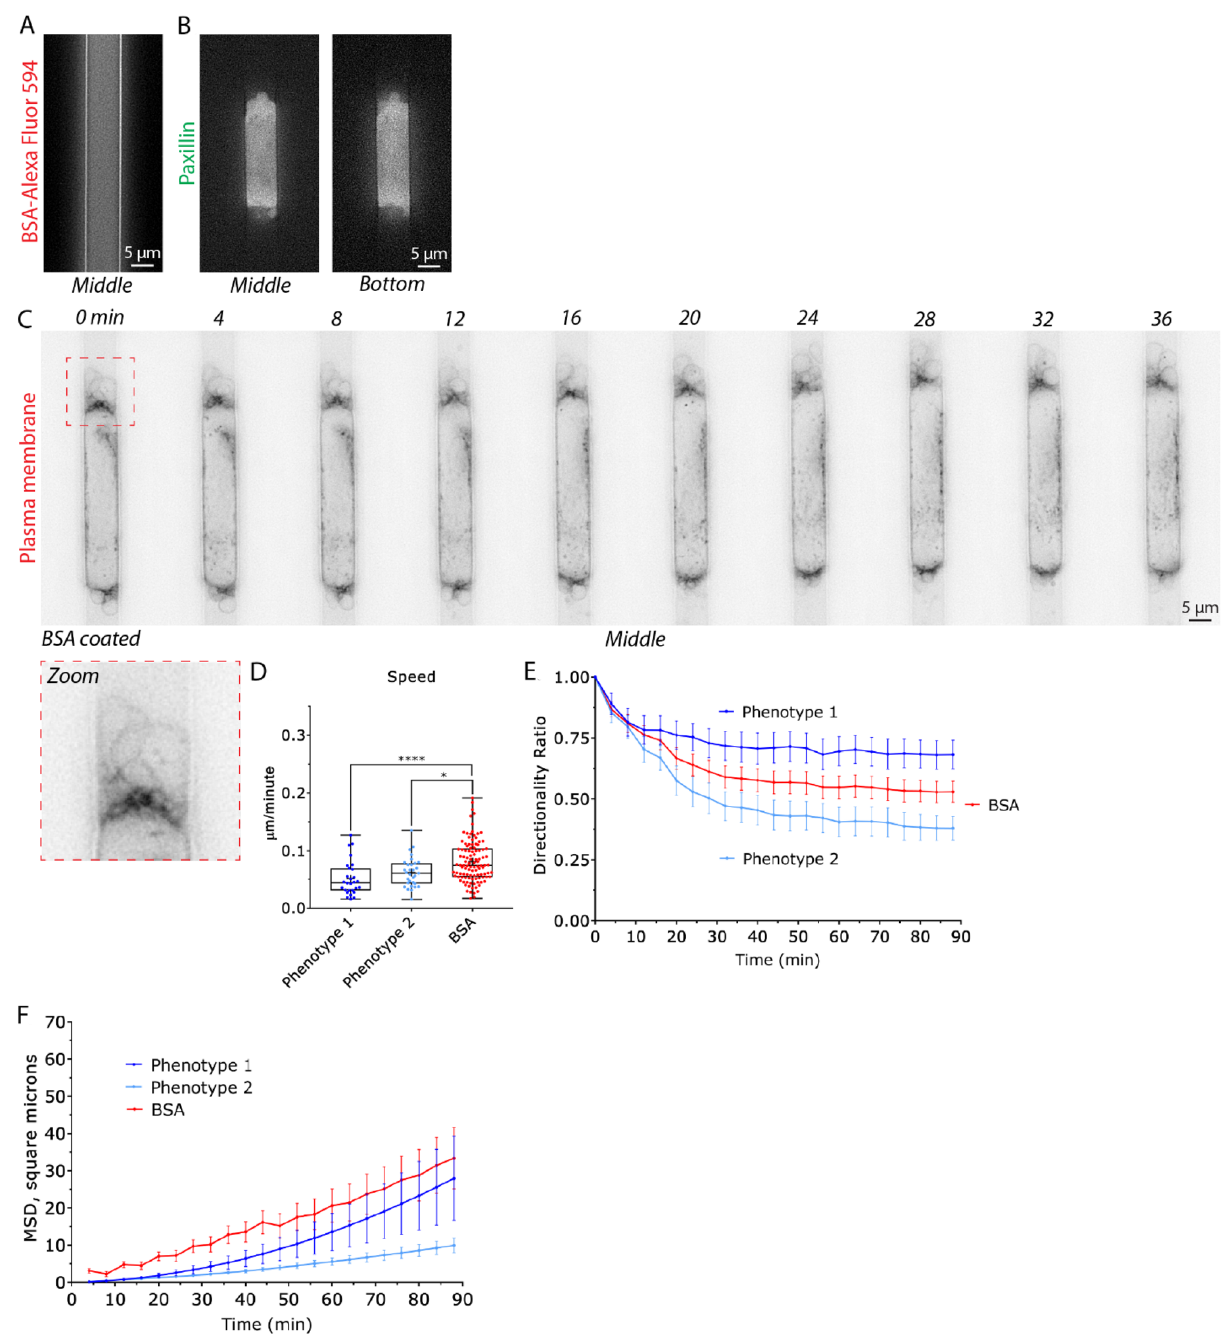
Figure 4. Blebbing cells in poorly adherent microchannels display increased migration parameters. ( A ) Confirmation that microchannels are coated with BSA, as indicated by fluorescence from Alexa Fluor 594 conjugated BSA (BSA-Alexa Fluor 594). ( B ) Confirmation that a melanoma A375-M2 cell with the focal adhesion marker, EGFP-paxillin, does not form focal adhesions within a BSA coated (1%) microchannel. Middle (left) and bottom (right) focal planes are shown. ( C ) Montage of a A375-M2 cell stained with a far red membrane dye, within a BSA coated microchannel. Zoom shows prominent blebs at the cell leading edge. ( D ) A comparison of instantaneous speeds for phenotype 1 (N = 28), 2 (N = 31), and for cells within BSA (N = 109) coated microchannels. Statistical significance was determined by a Dunn’s multiple-comparison test post-hoc. ( E ) A comparison of directionality ratio over time for phenotype 1 (N = 28), 2 (N = 31), and for cells within BSA (N = 109) coated microchannels. Error is SEM. ( F ) A comparison of Mean Square Displacement (MSD; square microns) over time for phenotype 1 (N = 28), 2 (N = 31), and for cells within BSA (N = 109) coated microchannels. All data are representative of at least three independent experiments. *— p ≤ 0.05, **— p ≤ 0.01, ***— p ≤ 0.001, and ****— p ≤